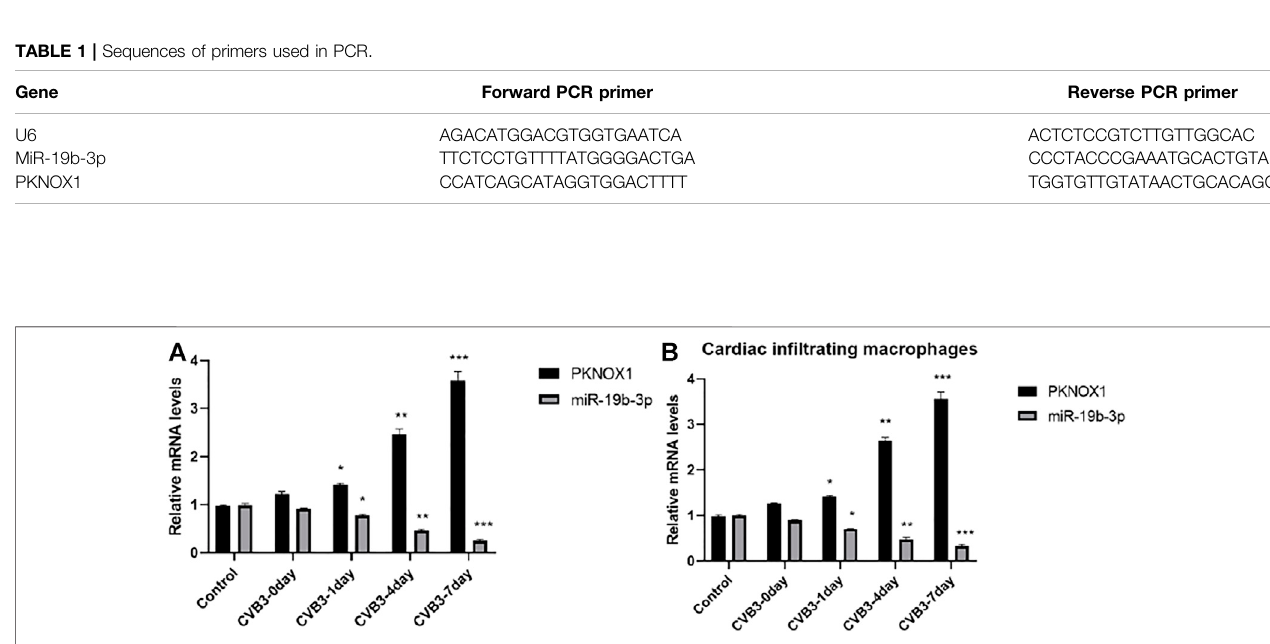
FIGURE 1 | Comparison of miR-19b-3p and PKNOX1 expression after different treatments. (A) PCR detection of miR-19b-3p and PKNOX1 expression in mouse hearttissueand (B) PCRdetectionofmiR-19b-3pandPKNOX1expressionincardiacin fi ltratingmacrophages.Comparedwiththecontrolgroup, p p < 0.05, pp p < 0.01, ppp p <